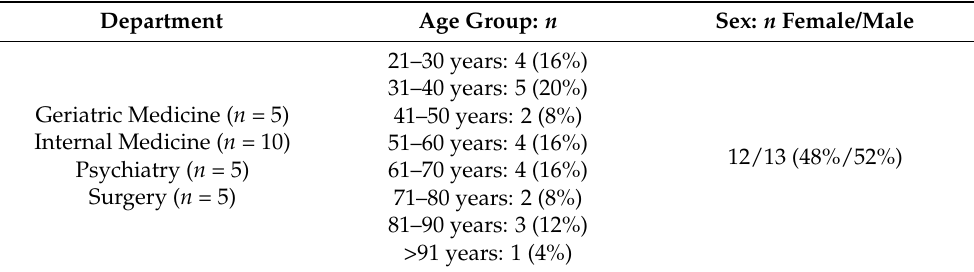
Table 1. Demographic properties of interviewees.